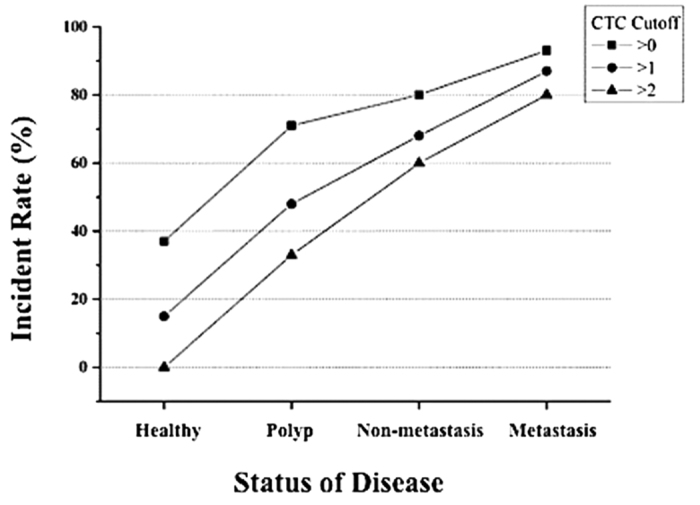
Percentage of patients that had CTC counts above the shown cutoff values as a function of disease status.Three levels of CTC count cutoffs were used: >0, >1, or >2, all per 2 mL of blood sample.